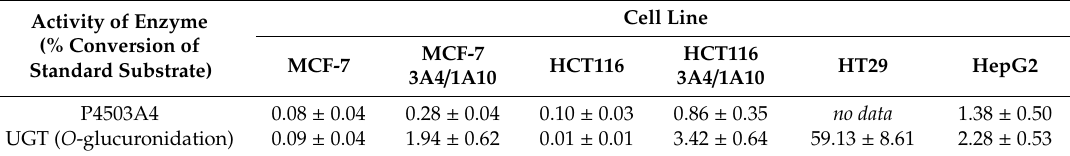
Table 1. Activity of P4503A4 isoenzyme and UGT enzymes performing O -glucuronidation in selected cell lines, native and transfected (3A4 / 1A10) calculated as % conversion of standard substrate for P4503A4 (testosterone) and O -glucuronidation process (7-OH-TFC). Cells were incubated with enzyme substrate in the same conditions for the same time: 24 h for testosterone and 3 h for 7-OH-TFC.